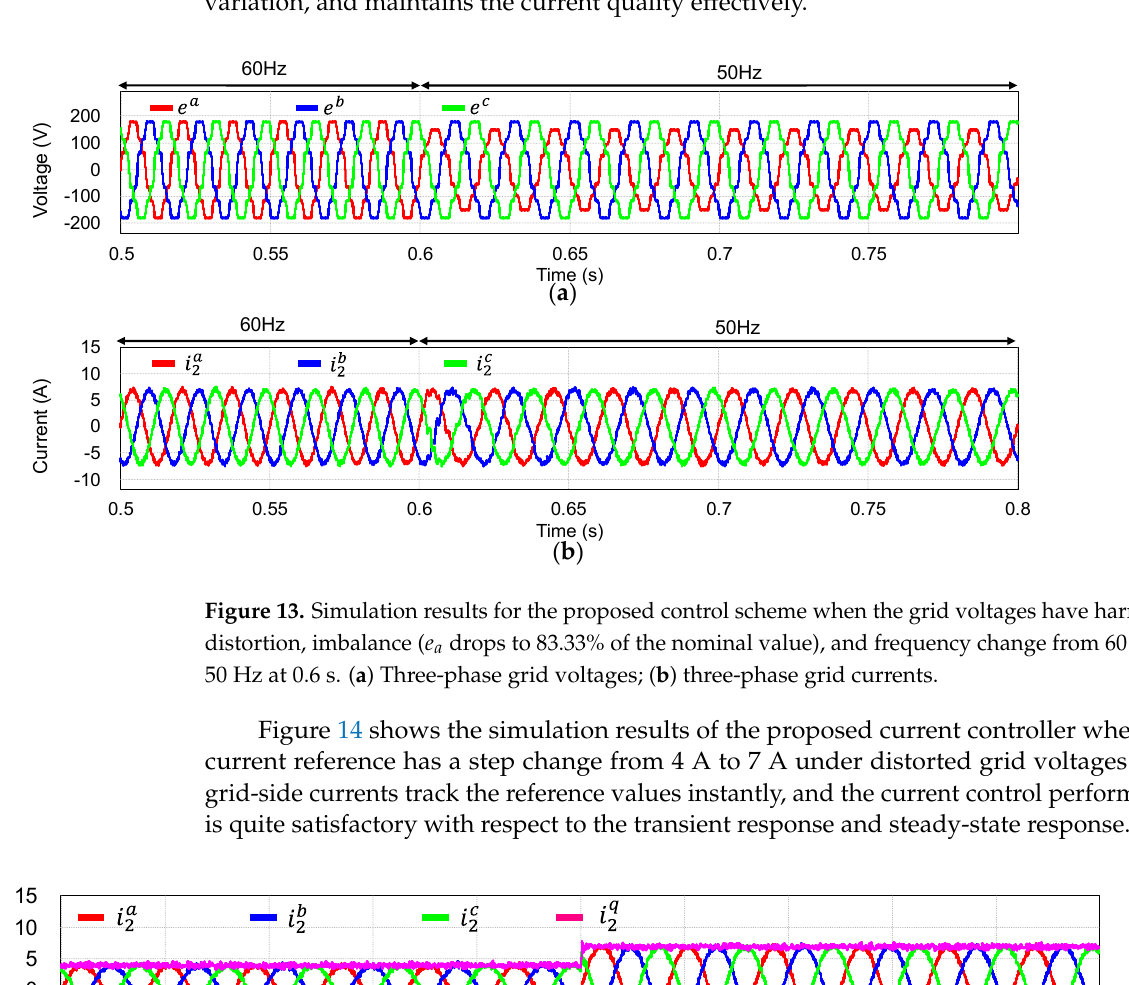
Figure 14. Simulation results of three-phase grid currents for the proposed control scheme under distorted grid voltages when the current reference has a step change from 4 A to 7 A.